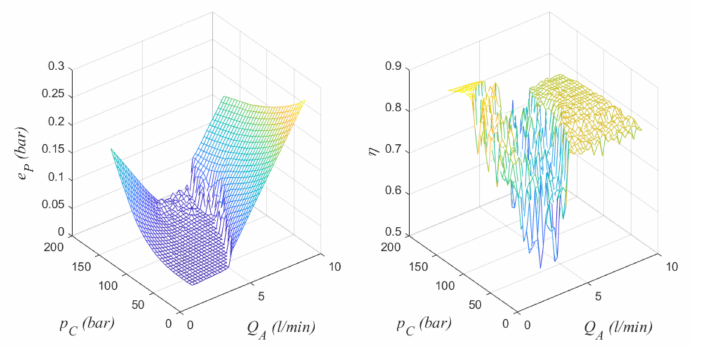
Figure 10. Pressure control error e P and recuperation efficiency as functions of input flow rate Q A and control pressure p C